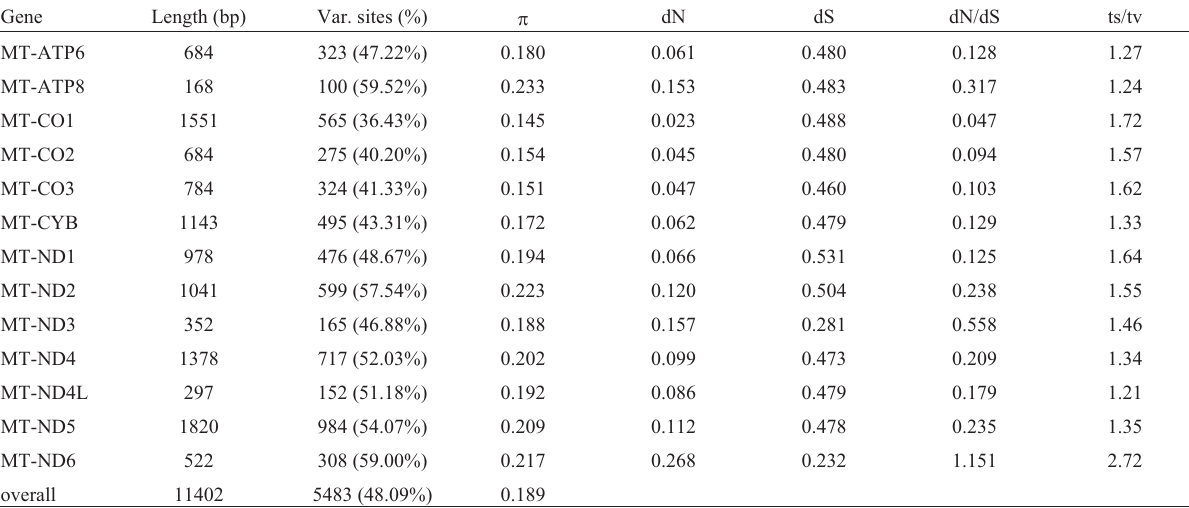
Table 2 - Rates and patterns of evolution among mitochondrial PCGs and 13 species of Coraciiformes. Gene Length